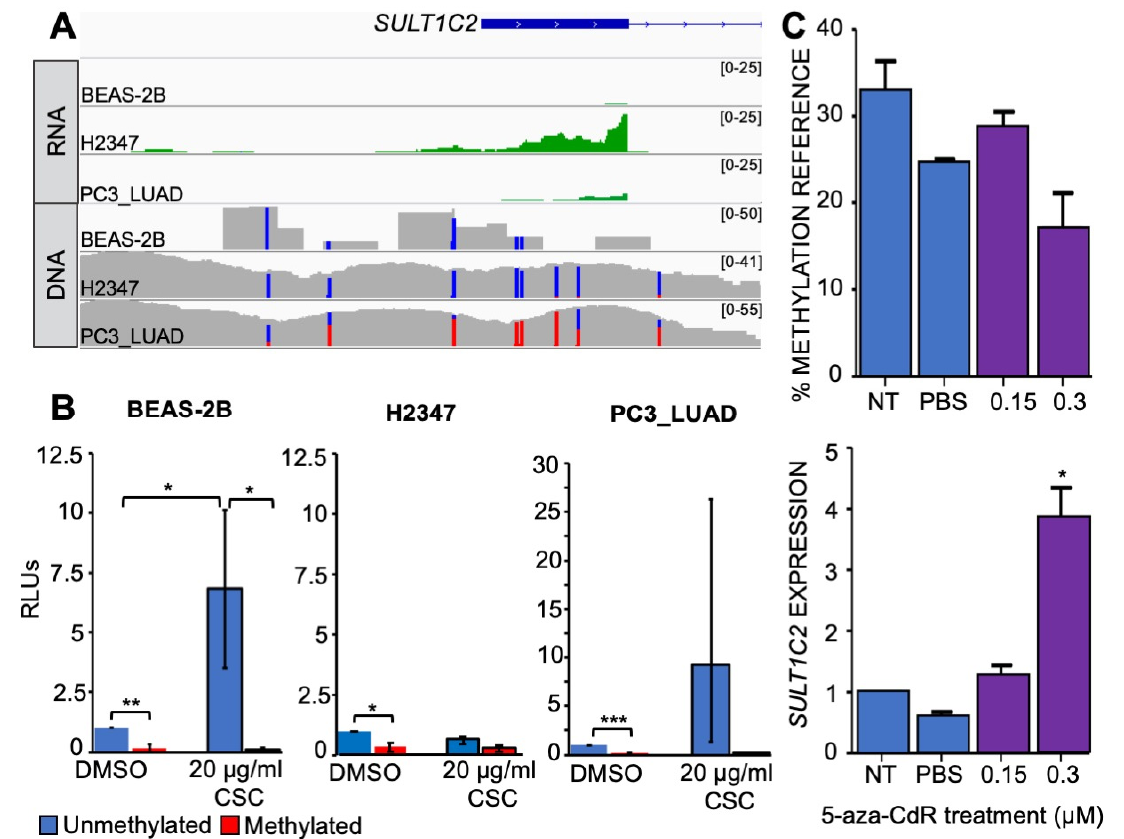
Figure 3. DNA methylation represses transcription of SULT1C2 promoter. ( A ) IGV browser image of SULT1C2 promoter region. RNAseq (green) was downloaded from publicly available resources [32,33]. BAM alignment files to hg19 genome displayed. DNA includes RRBS (BEAS-2B) and sWGBS (H2347, PC3_LUAD); blue = unmethylated, red = methylated, gray = non-CpG sequence. ( B ) Cells were transfected with in vitro SssI-methylated or -unmethylated SULT1C2 -CpGless vector in the indicated cell lines. Cells were subsequently treated with 20 μ g/mL CSC for 24 h. Samples were background-subtracted and normalized to CMV-luciferase positive controls as a measure of transfection efficiency. RLUs are expressed as a ratio relative to unmethylated, untreated controls in the indicated cell line. Blue = unmethylated SULTC2 promoter, red = methylated SULT1C2 promoter. Black outlines indicate CSC-treated samples. n = 3. A two-tailed paired t test was used to calculate significance and Bonferroni correction applied for multiple tests; (*) = p ≤ 0.05, (**) = p < 0.01, (***) p < 0.001. ( C ) PC3_LUAD cells, the only cell line in our study with significant endogenous methylation of the SULT1C2 promoter, were treated with 5-aza-CdR at half the clinical dose (0.15 μ M) and the clinical dose (0.30 μ M). Pyrosequencing was used to determine differential methylation by percent methylated reference (PMR) to Alu. SULT1C2 expression was normalized to LACTB loading controls. n = 3.